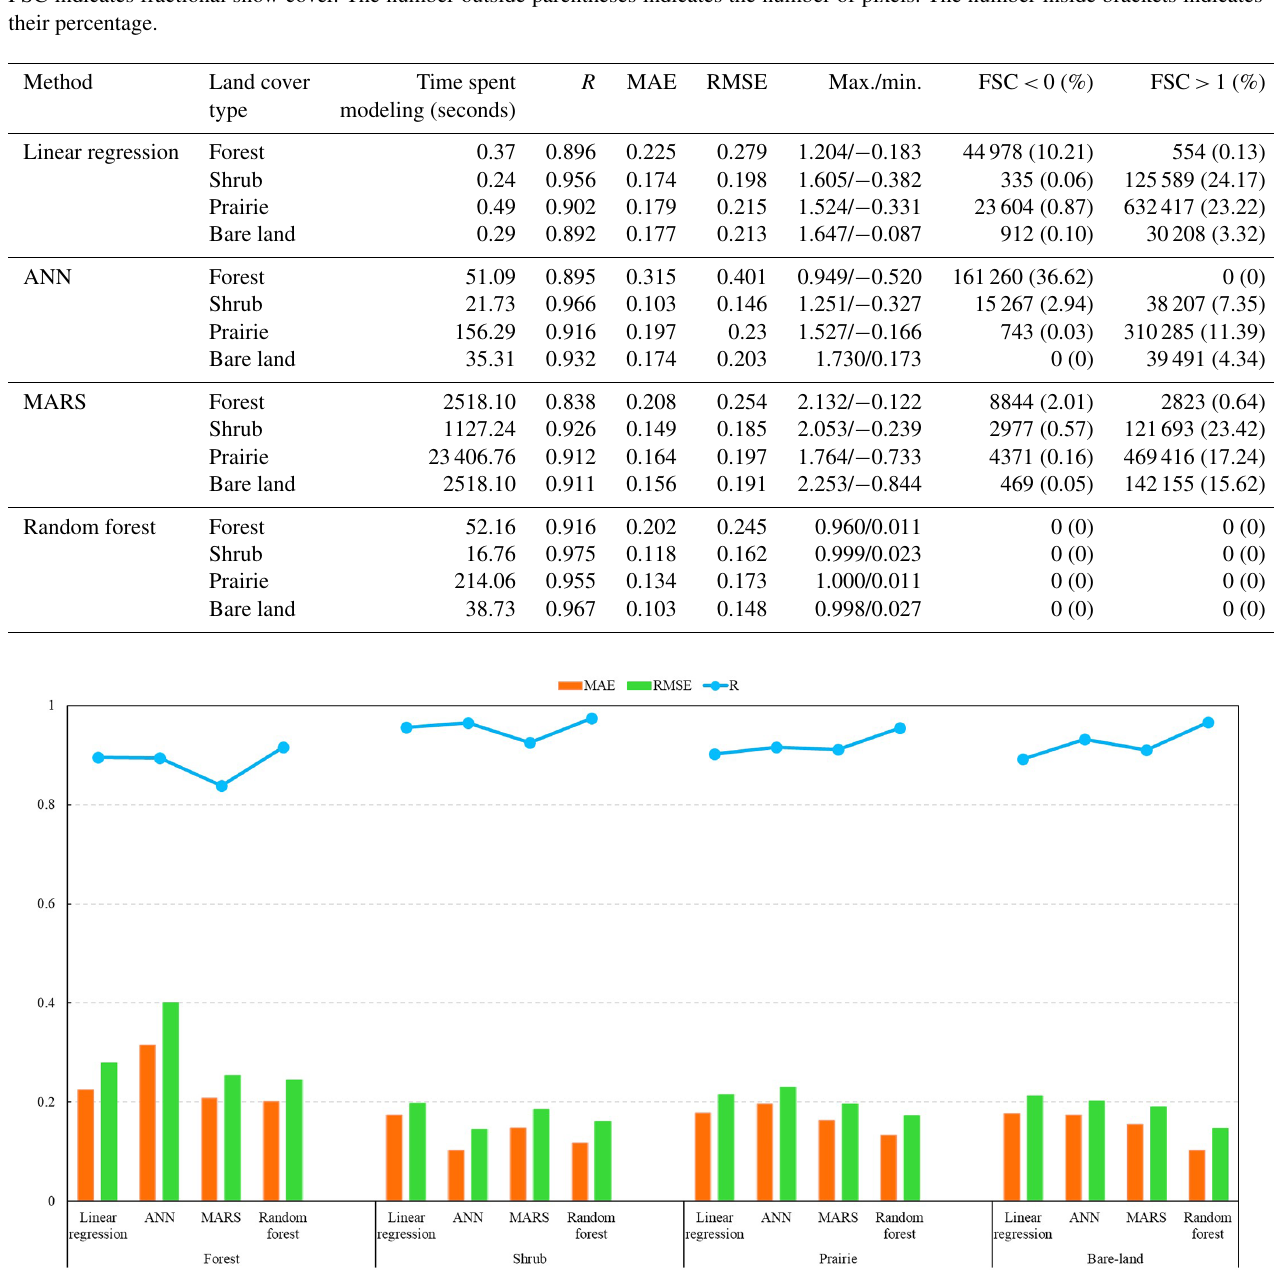
Figure 5. The variation in the accuracy indexes (MAE, RMSE, and R ) of the four algorithms (linear regression, ANN, MARS, and random forest) for four land